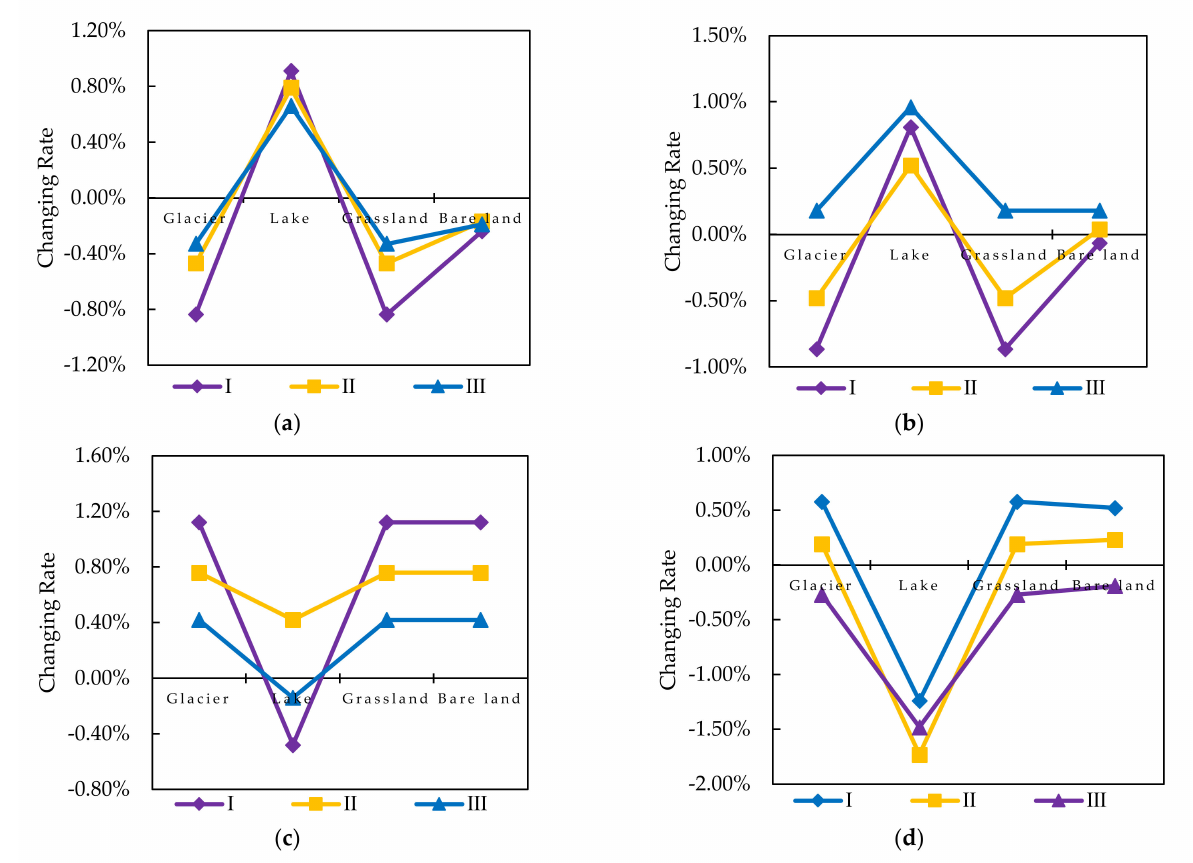
Figure 20. The multiscale change rate of the different eco-environment elements. ( a ) Large scale; ( b ) medium scale; ( c ) small scale; ( d ) smaller scale.